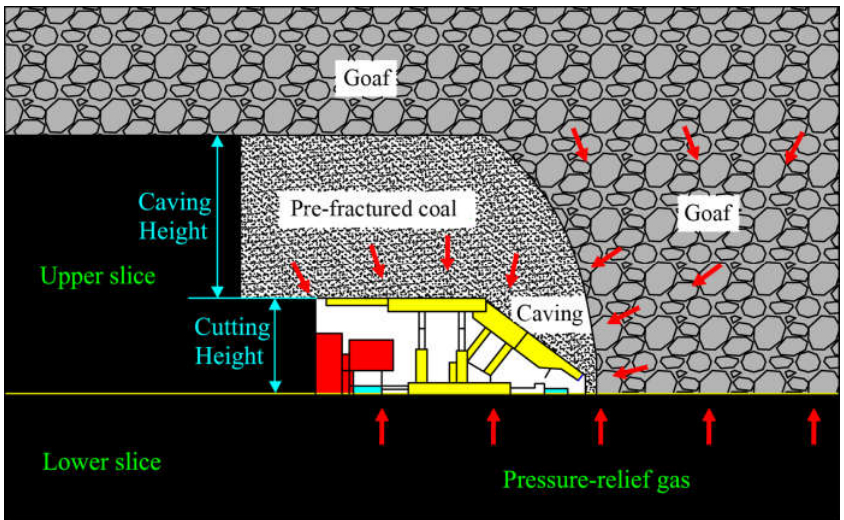
Figure 13. The gas emission sources in the working face.